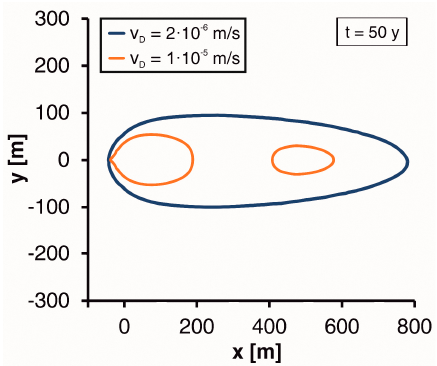
Figure 5. Time evolution of plume dimensions with Darcy velocity v D ( a ) and effective porosity n e ( b ); isotherm ∆ T = 1 °C.